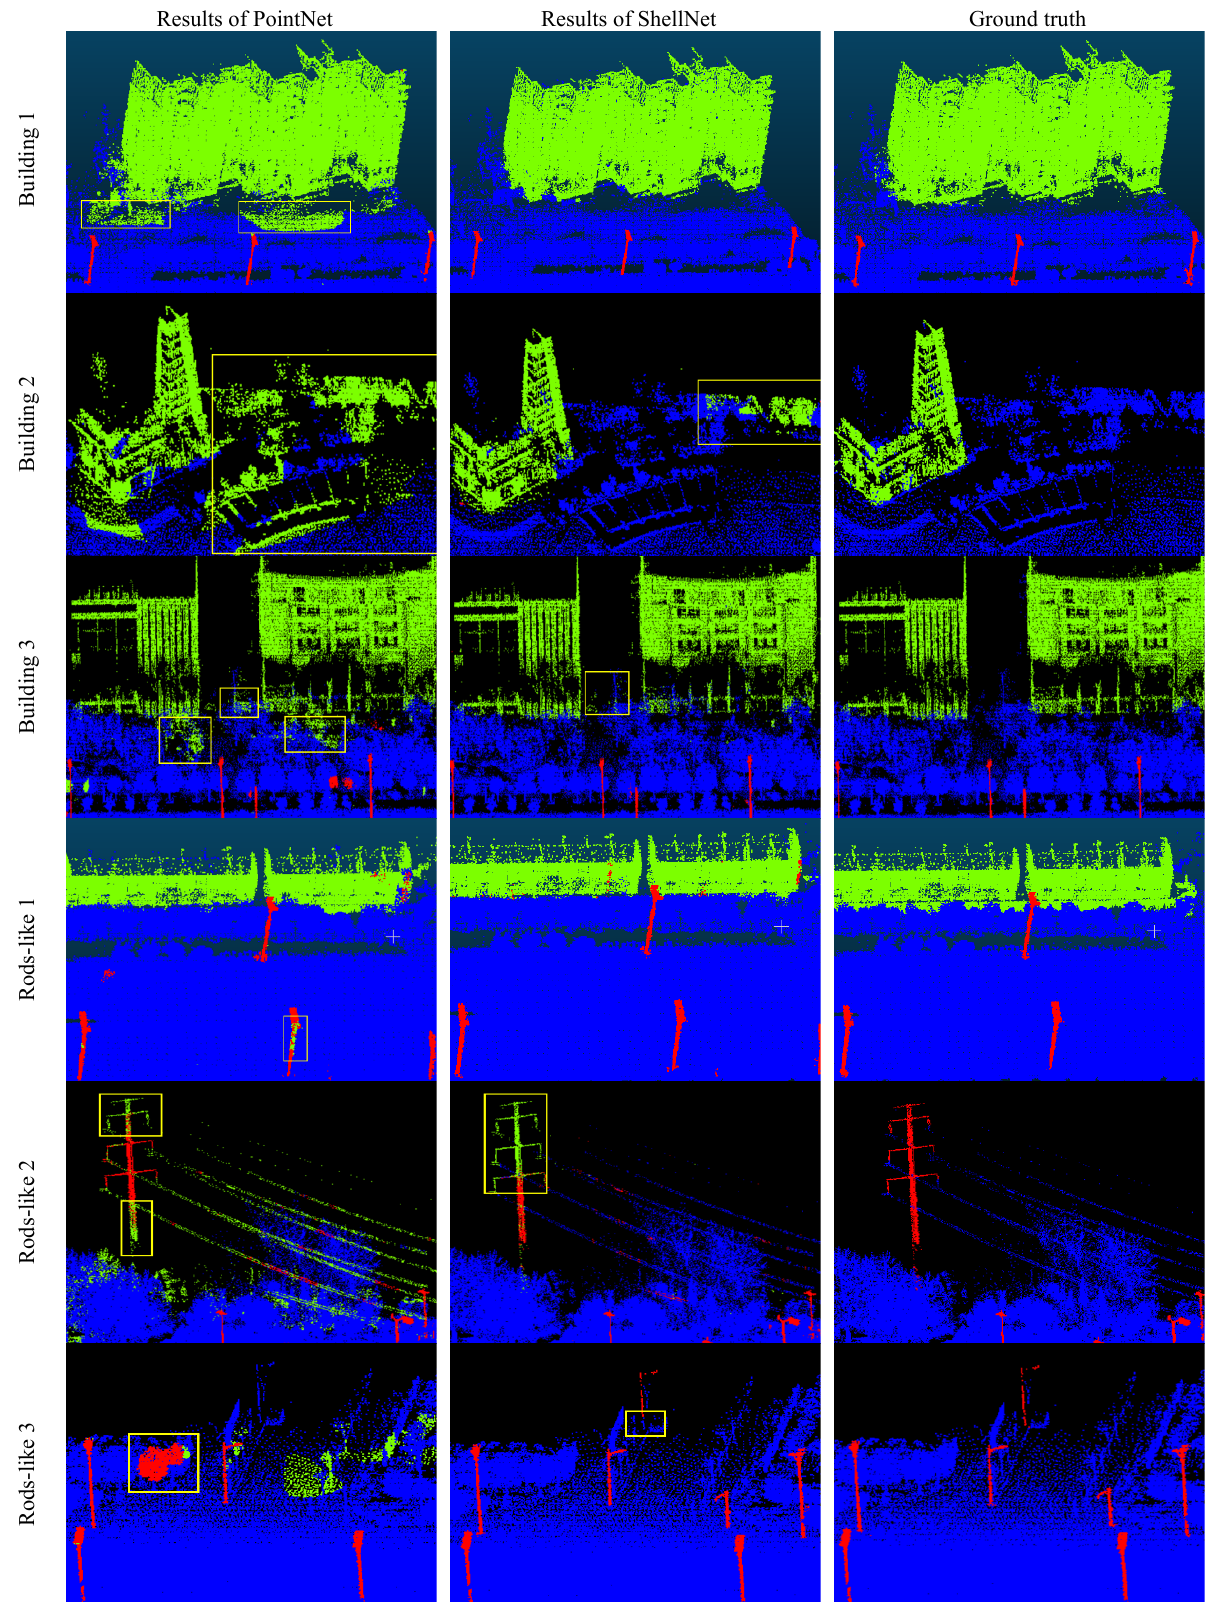
Figure 6. Test results for buildings, rods-like, and other objects. For obvious contrast, ground truth values and results are rendered in different colors, with buildings rendered in green, poles in red, and other objects in blue. Yellow rectangles show misclassified